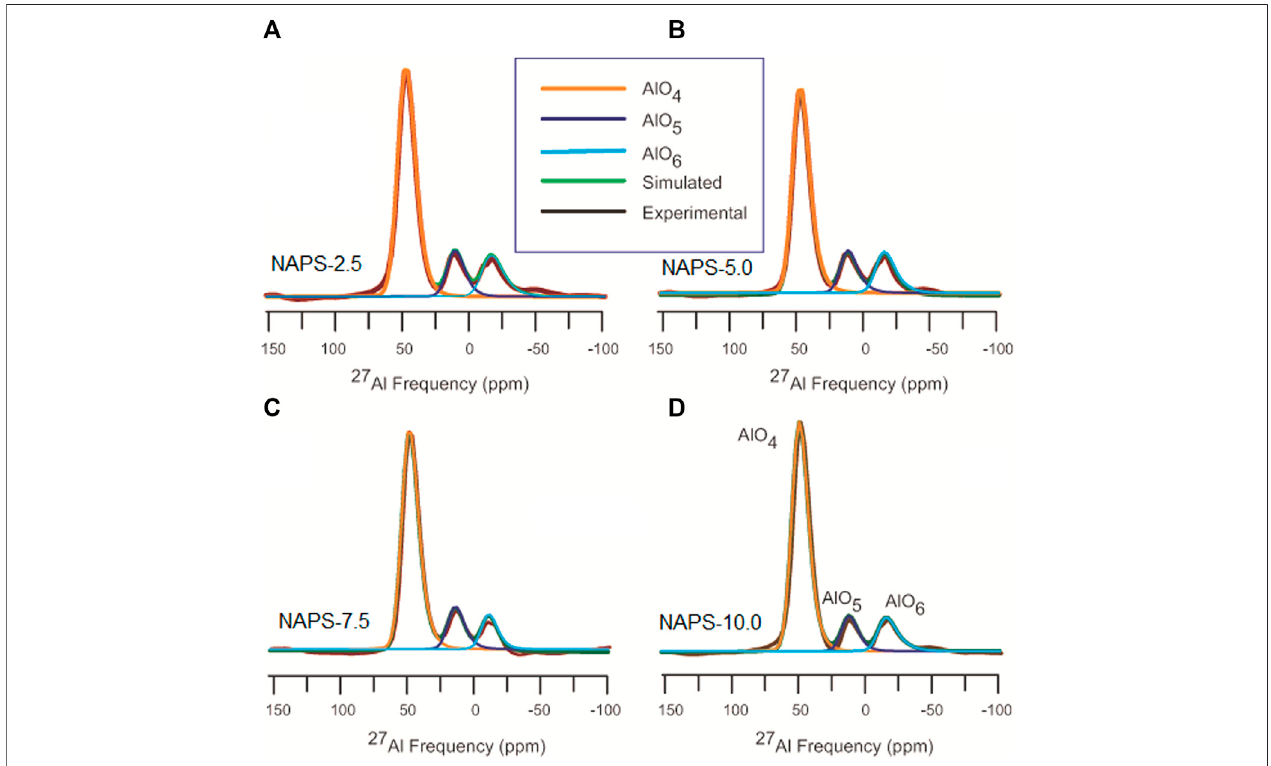
FIGURE 3 | Deconvolution of 27 Al MAS-NMR spectra using czSimple model using DM fi t software. The insert shows simulated and experimental spectra of central transition.